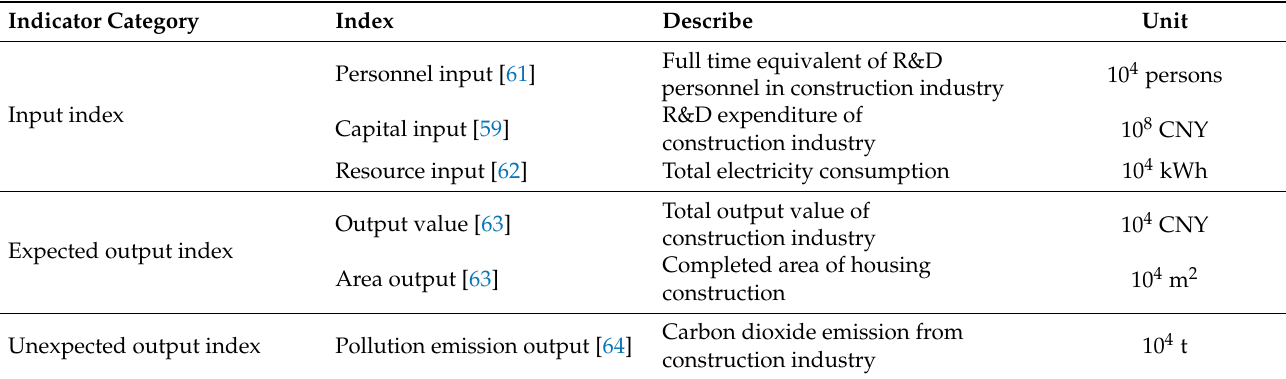
Table 2. Green technology innovation efficiency index